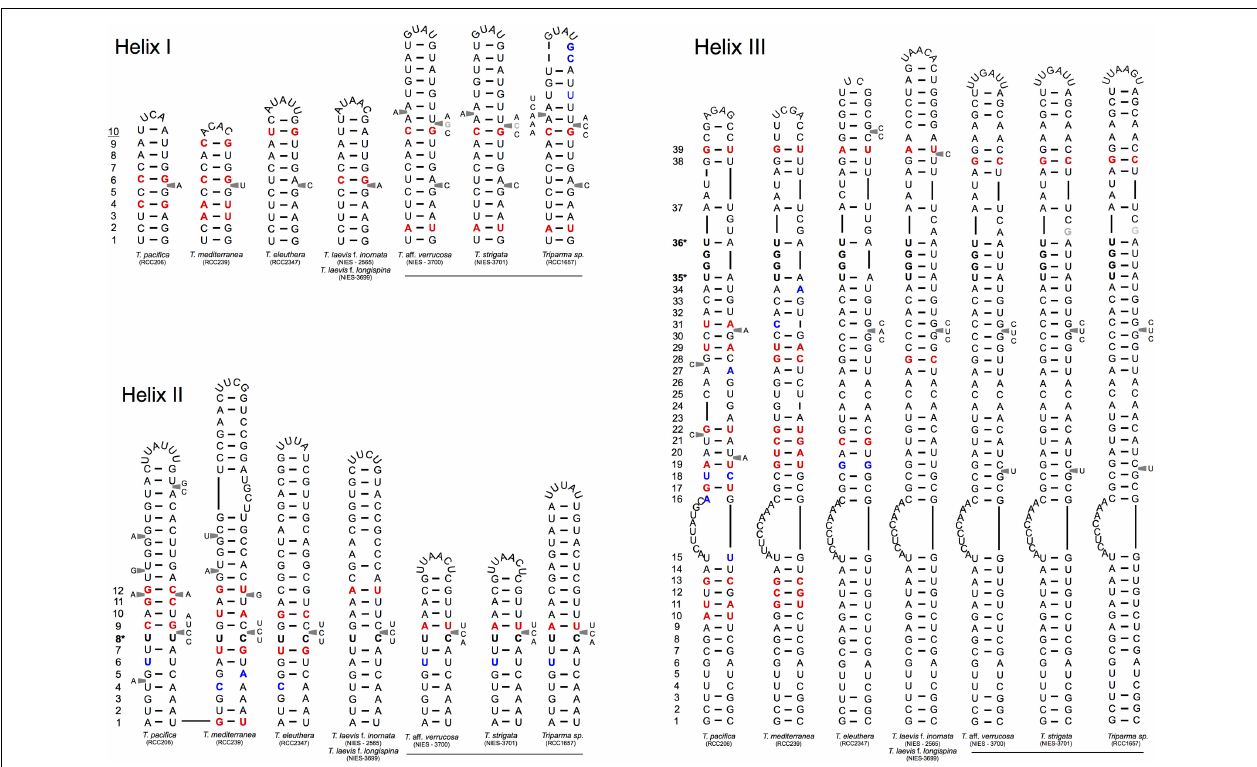
FIGURE 4 | Simplified secondary structural diagram of helices I, II, and III among the different T riparma clades. The conserved base pair among the different clades are numbered. Double-sided CBCs (compensatory base changes) and hemi-CBCs are highlighted by bold red nucleotides. Non-CBCs (N – N ↔ N × N) are represented by bold blue nucleotides. The pyrimidine-pyrimidine (Y–Y) mismatch in helix II and the YRRY (pyrimidine – purine – pyrimidine) motif on the 5 (cid:48) side arm of the helix III are showed by bold nucleotides and by ∗ positions. Single nucleotide substitution between T. aff. verrucosa and T. strigata is showed by gray nucleotides (see Methodology in Supplementary Material